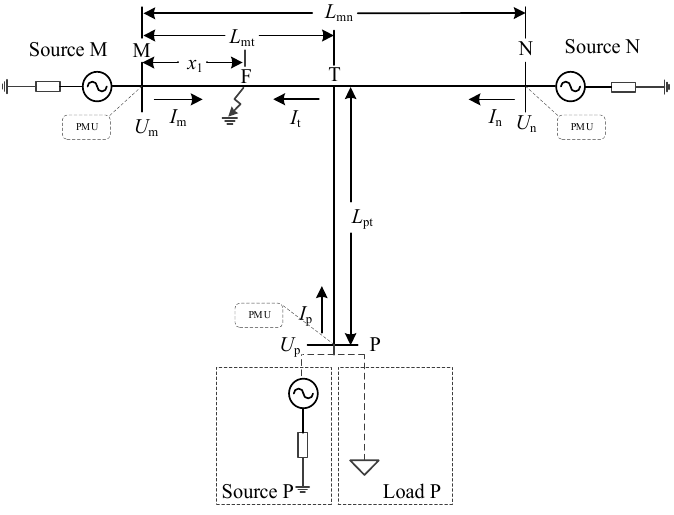
Figure 1. T-type transmission line structure.